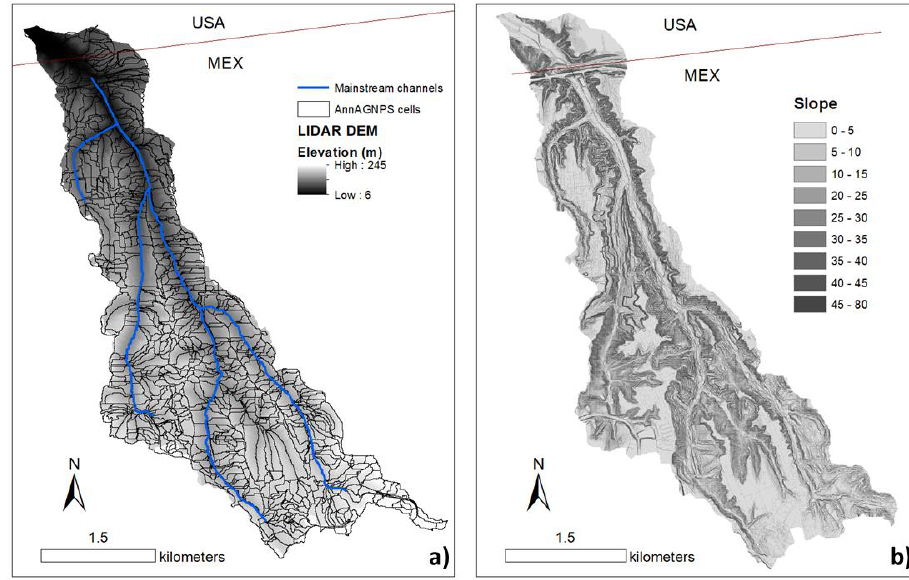
Figure 4. ( a ) AnnAGNPS cells, reaches, mainstream channels, and ( b ) slope gradient at the Los Laureles Canyon watershed